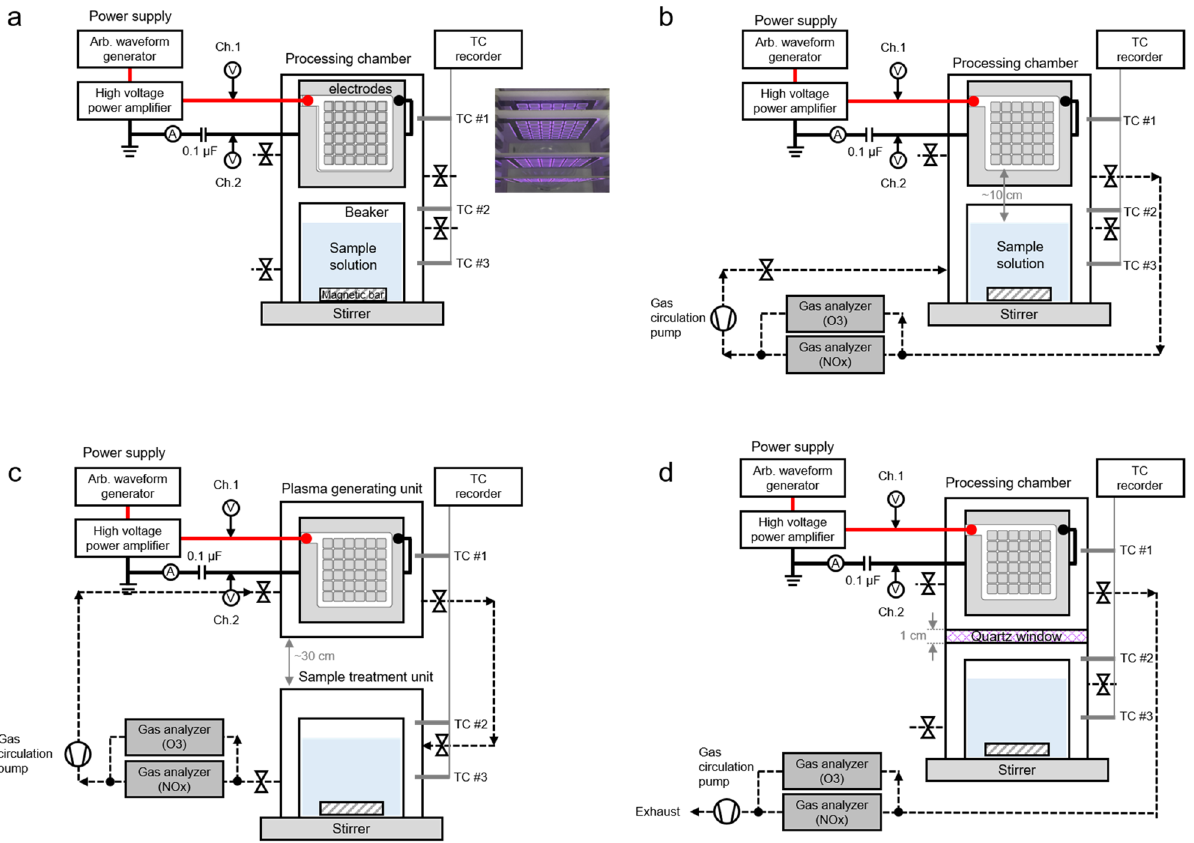
Figure 1. Schematic drawing of the test setup for the plasma treatment: ( a ) direct plasma treatment without gas circulation, ( b ) direct plasma treatment with gas circulation, ( c ) indirect plasma treatment to confirm the effect of the plasma reactive species with gas circulation, and ( d ) indirect plasma treatment to confirm the effect without the plasma reactive species and with gas